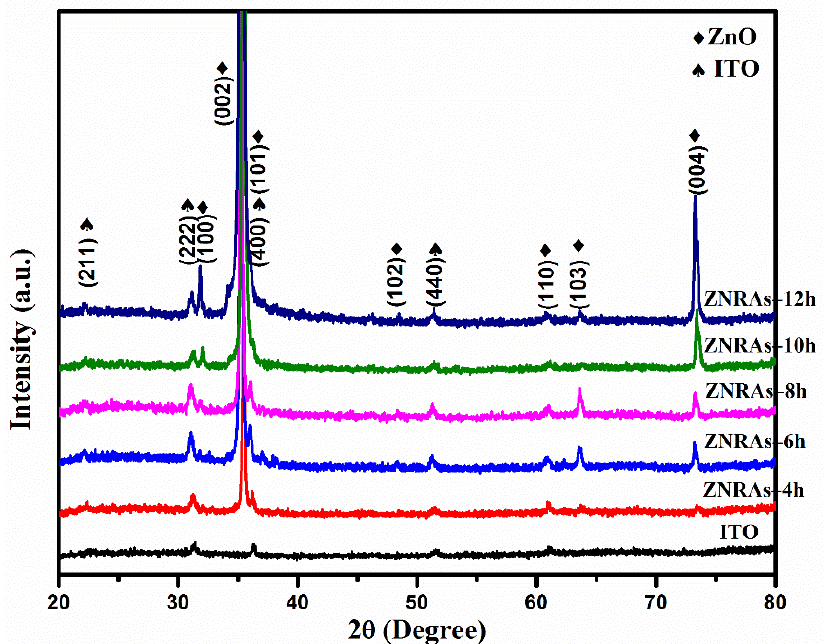
Figure 2. XRD profiles of ITO and ZNRAs made at various hydrothermal growth times.